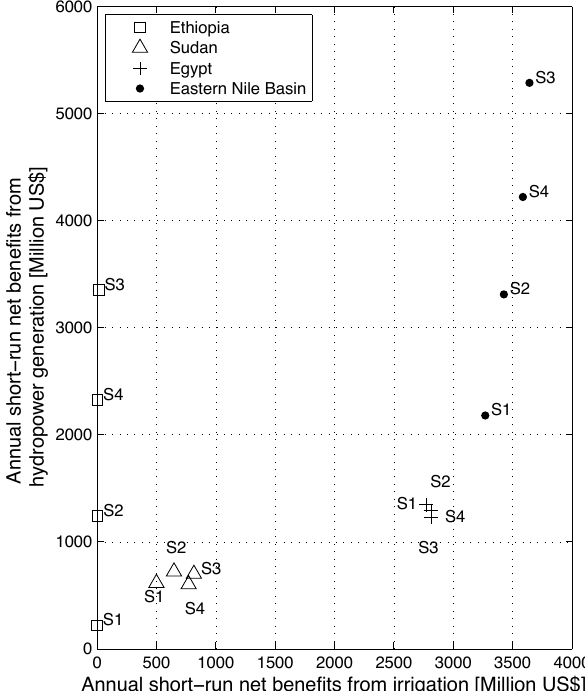
Fig. 12. Average annual short-run net benefits from hydropower generation and irrigation.